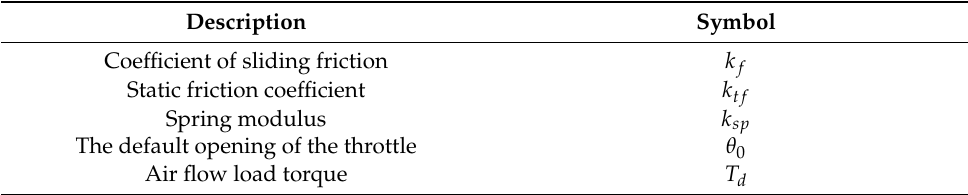
Table 1. Parameters of the Throttle Model.